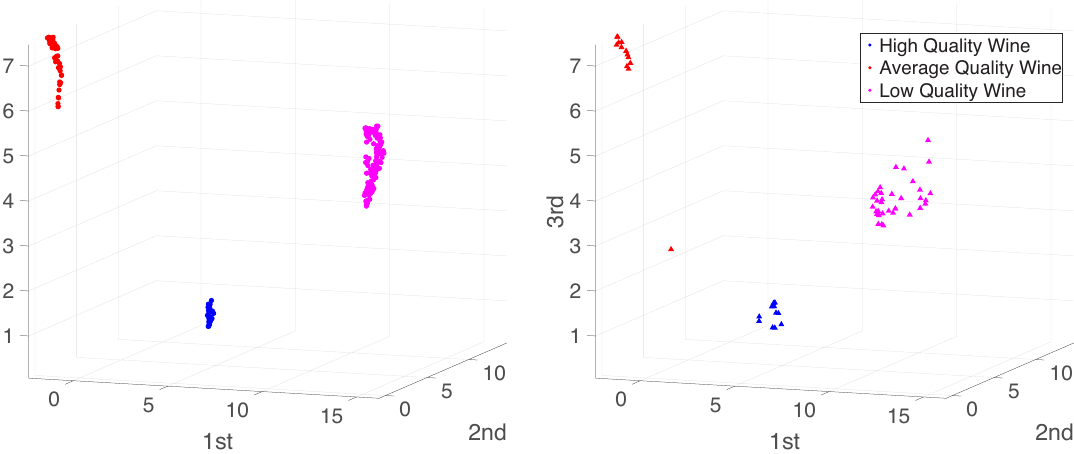
Figure 15. Scatter plot of the first three UMAP features of the data in dataset #2 (the training set is on the left and the test set is on the right). The three qualities of the wine are shown in different